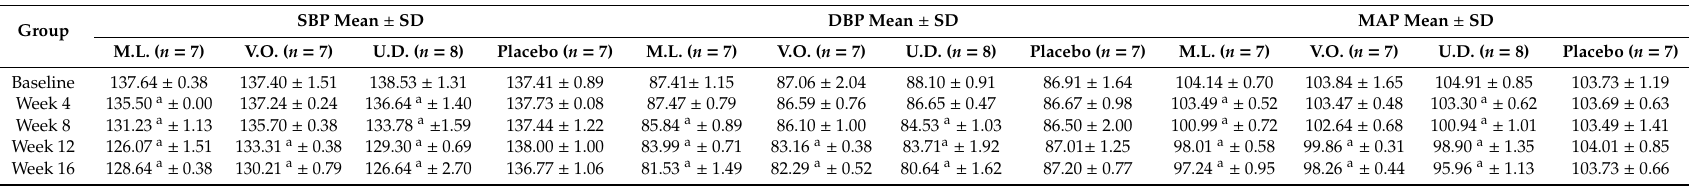
Table 3. Means ± SD of SBP, DBP and MAP measured over 16 week intake of 300 mL / day of M. longifolia (M.L.), V.odorata (V.O.) and U. dioica (U.D.) in mild hypertensive